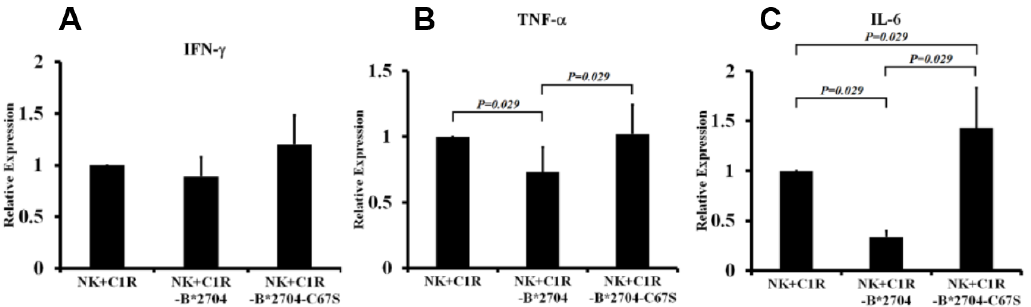
Figure 4. The effect of co-culturing with C1R, C1R-B*2704 C67S, or C1R-B*2704 cells on the cyto- kine expression of NK-92MI cells. After co-culturing with C1R, C1R-B*2704, or C1R-B*2704 C67S, NK-92MI cells were isolated by using the EasySep™ Human NK Cell Isolation Kit. The total RNAs of treated NK-92MI cells were isolated by using the QIAamp RNA Blood Mini kit (QI-